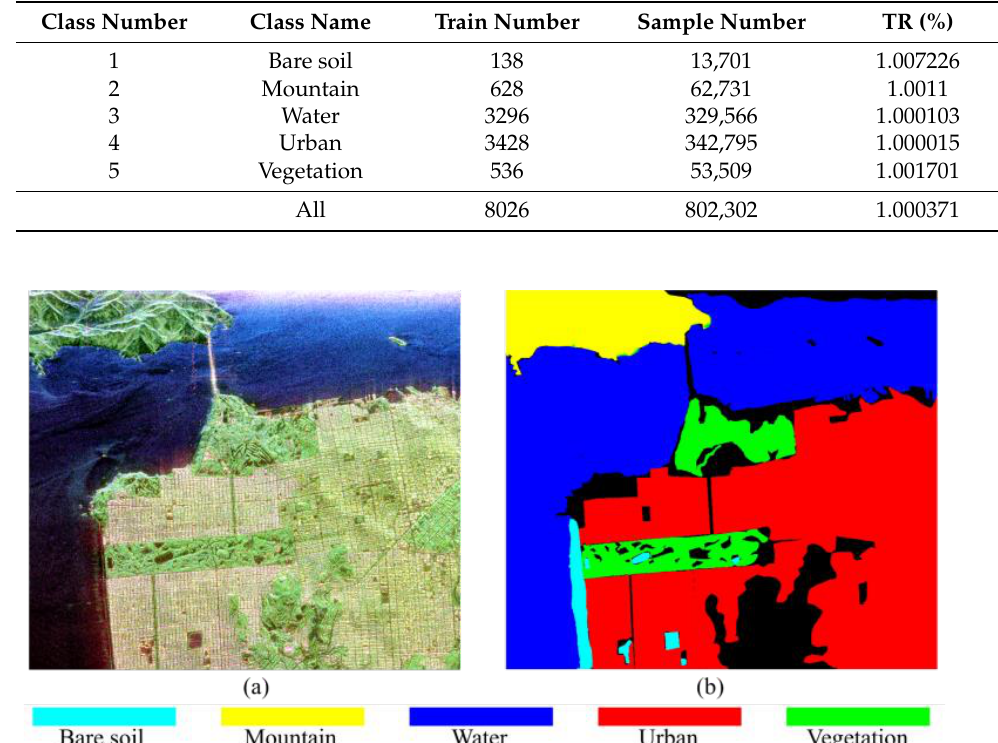
Figure 6. ( a ) Pauli RGB and ( b ) ground truth map of AIRSAR San Francisco data. As a preprocessing step, a refined Lee filter with a 7 × 7 window size is applied to Table 2. Details of classes and training samples for AIRSAR San Francisco data (TR represents train- both AIRSAR images to reduce the influence of speckle ing ratio).